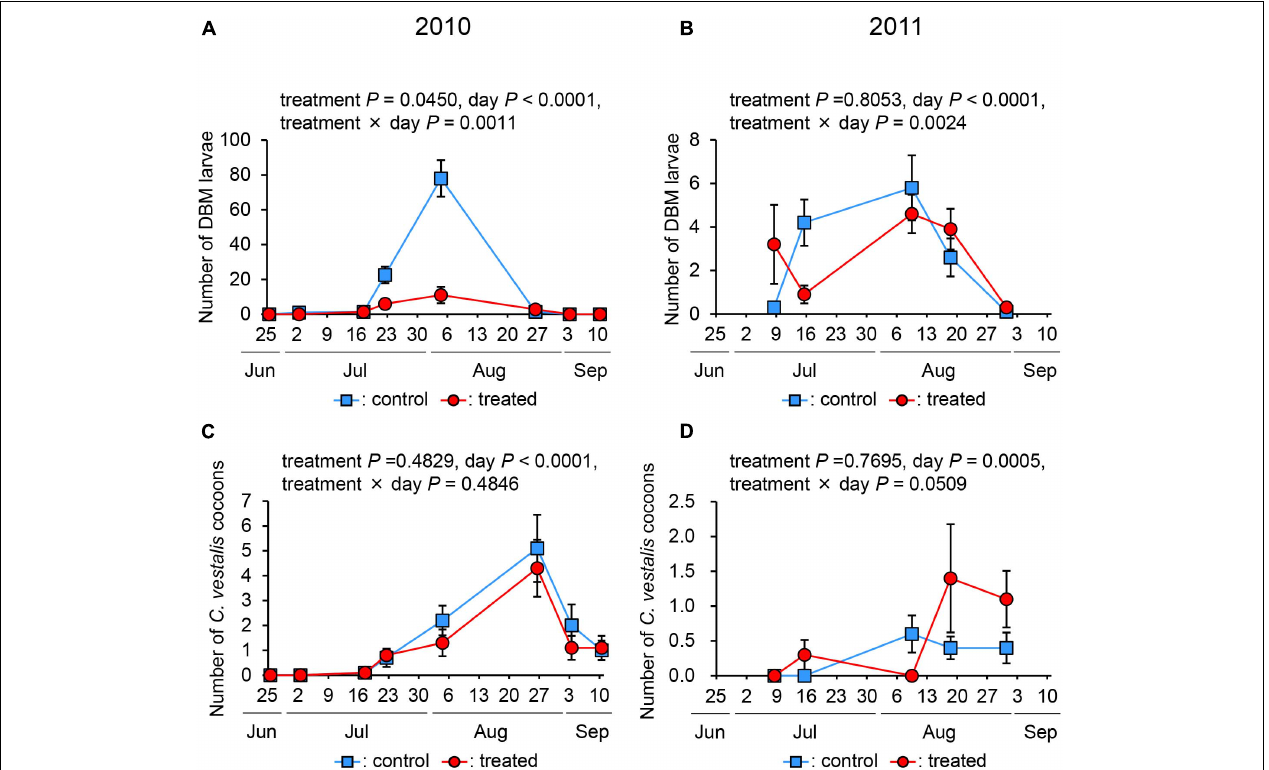
FIGURE 1 | The number of diamondback moth larvae (A,B) and Cotesia vestalis cocoons (C,D) in treated and control plots in 2010 and 2011.